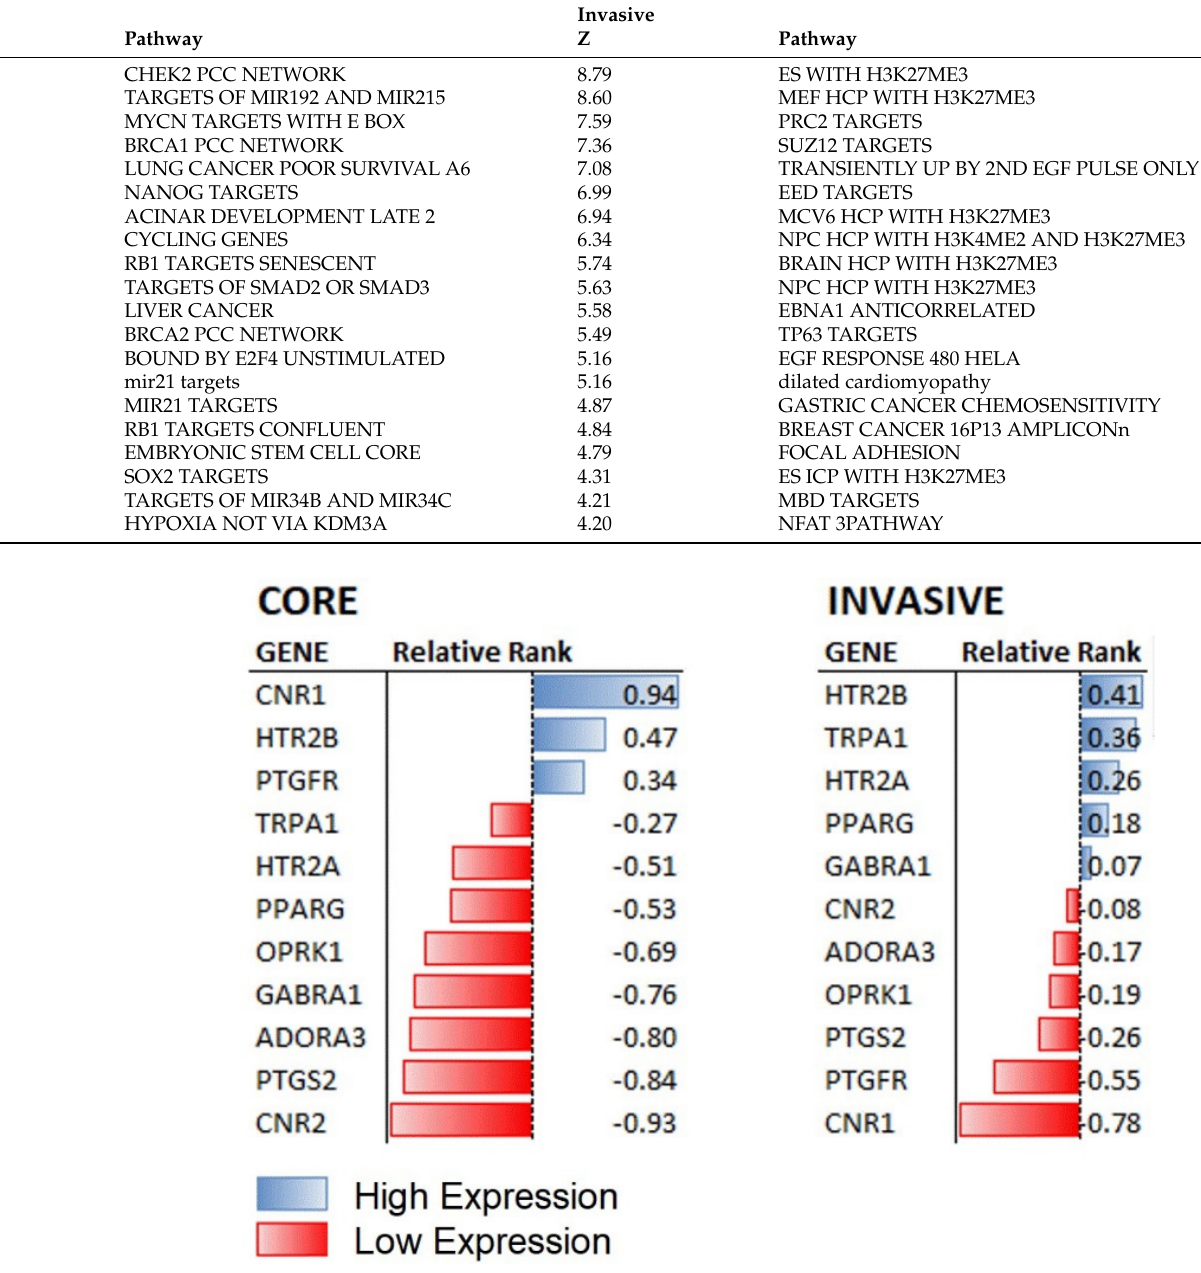
Figure 1. The relative expression levels of candidate targets for AM630 in the core and invasive cell populations. Genes that are reported as off-target for AM630 are expressed at different levels in the two cell populations with the CB1 receptor (CNR1) showing the highest expression in the core cells, indicating that the dominant activity elicited by AM630 in this population will most likely be mediated through this receptor, shown at left. In contrast, the invasive margin cells do not have conspicuously high CNR1 expression, shown at right. Only the 5-HT serotonin receptor HTR2B is upregulated in both populations, suggesting that a shared activity of AM630 might involve serotonin receptor antagonism. See Table S1 for the full rank profiles for the U87 and GIN-8